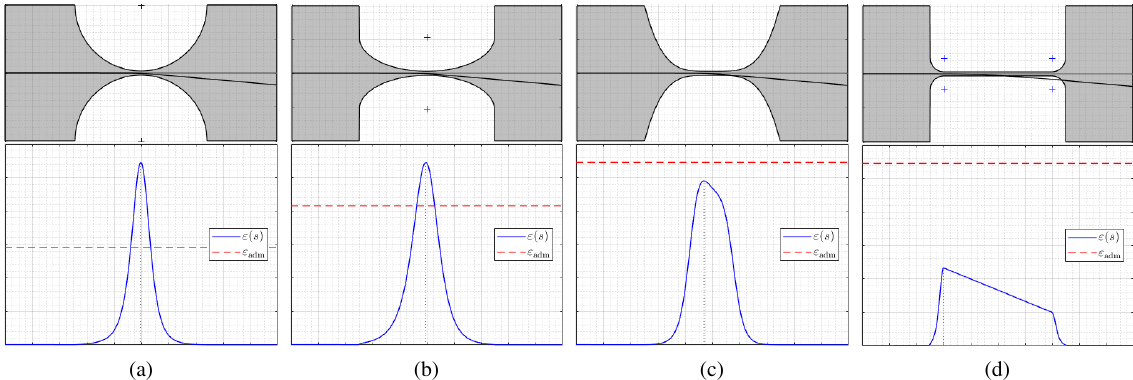
Figure 9. Example results of the deformed neutral axis and the outer fiber strain distribution for a force load computed for an angle input of | ϕ | = 5 ◦ ( β L = 2, β l = 1, β h = 0 . 03; result values see Table 3): (a) circular contour, (b) elliptical contour, (c) power function-based contour with n = 4, (d) corner-filleted contour.